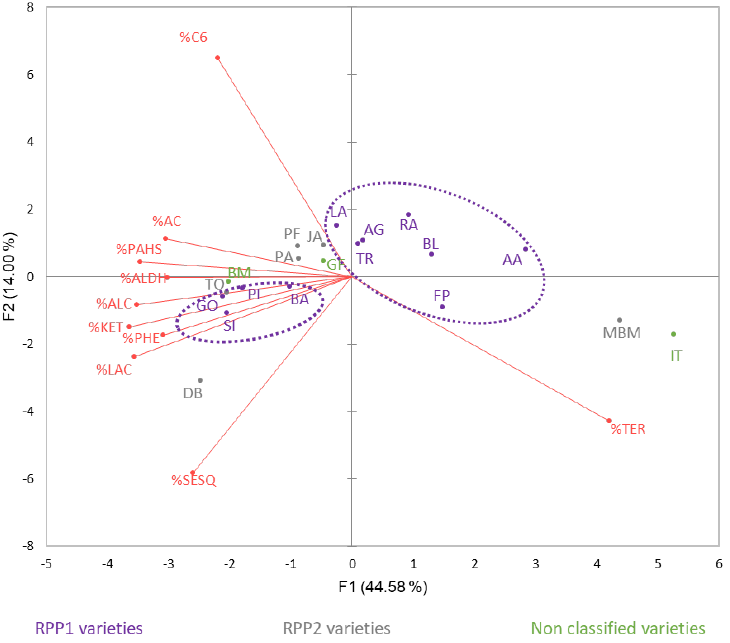
Figure 2. Principal component analysis of the free-aromatic-fraction profile (percentage) of